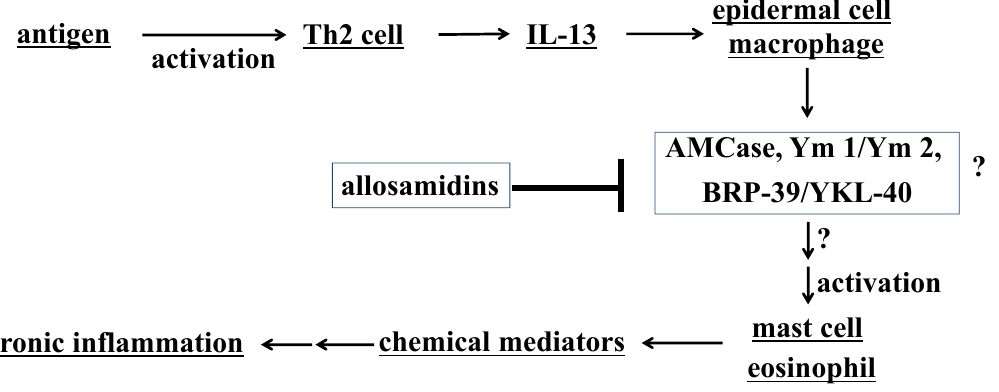
Figure 5. Asthma, and chitinase and chitinase-like